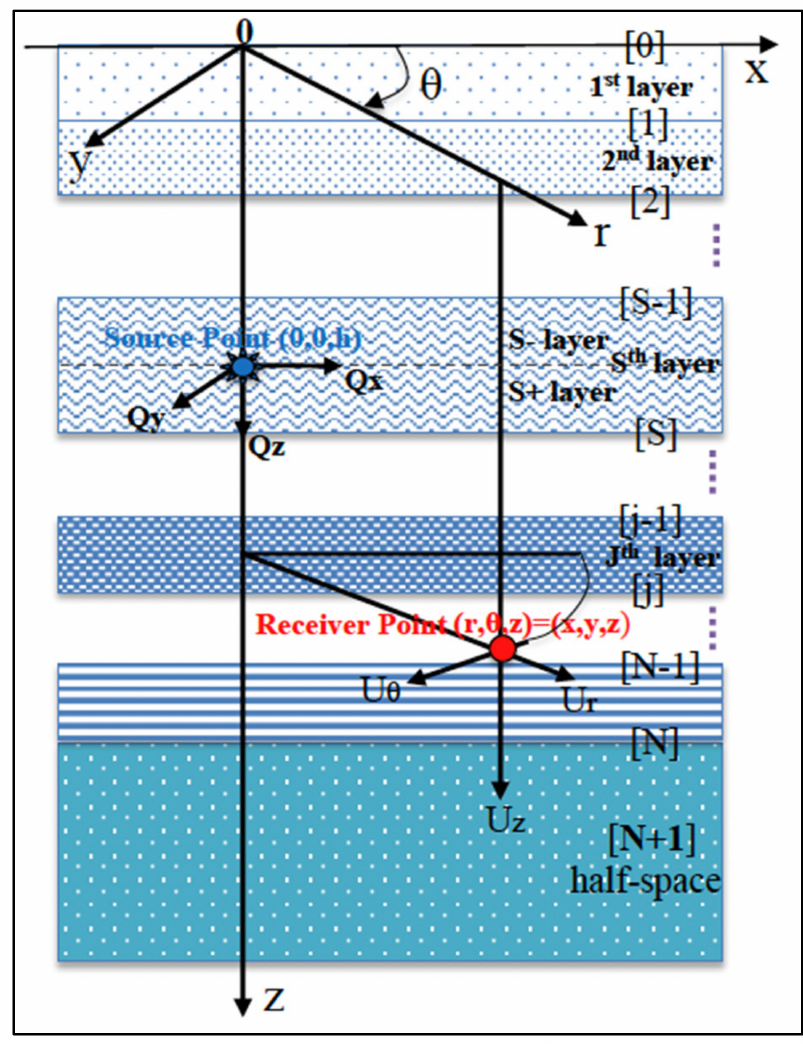
Figure 11. The multi-layered half space model considered by [64]. Point sources are located at the Z axis, and receivers at (r, θ , z), with the displacement components of the Green’s functions U r , U θ , U z (modified from